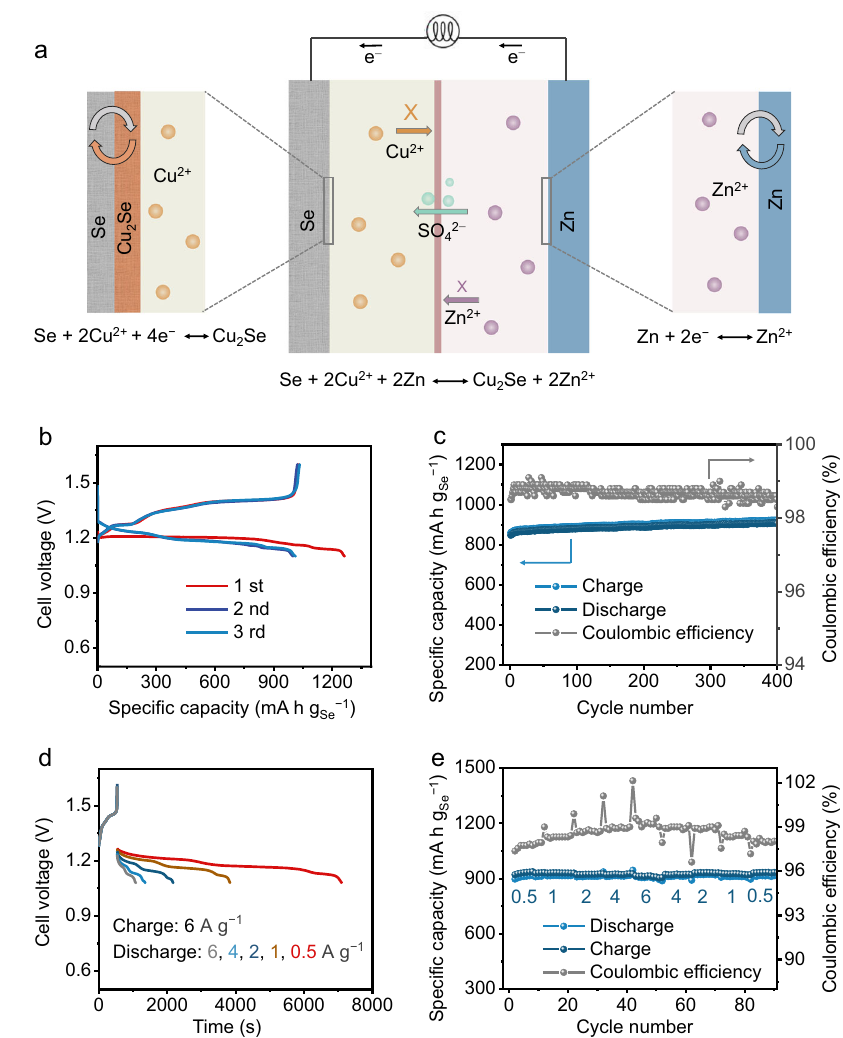
Fig. 7 Electrochemical energy storage testing of the Zn|0.5 M ZnSO 4 ||0.5 CuSO 4 |Se@C full cells. a Schematic diagram of the aqueous Zn||Se@C-48 full cell. b GCD curves of the fi rst three cycles at 0.5 A g − 1 and c the cycling performance at 2 A g − 1 . d , e The fast-charging rate performance of the aqueous Zn||Se@C-48 full cell: charging at 6 A g − 1 , discharging at different